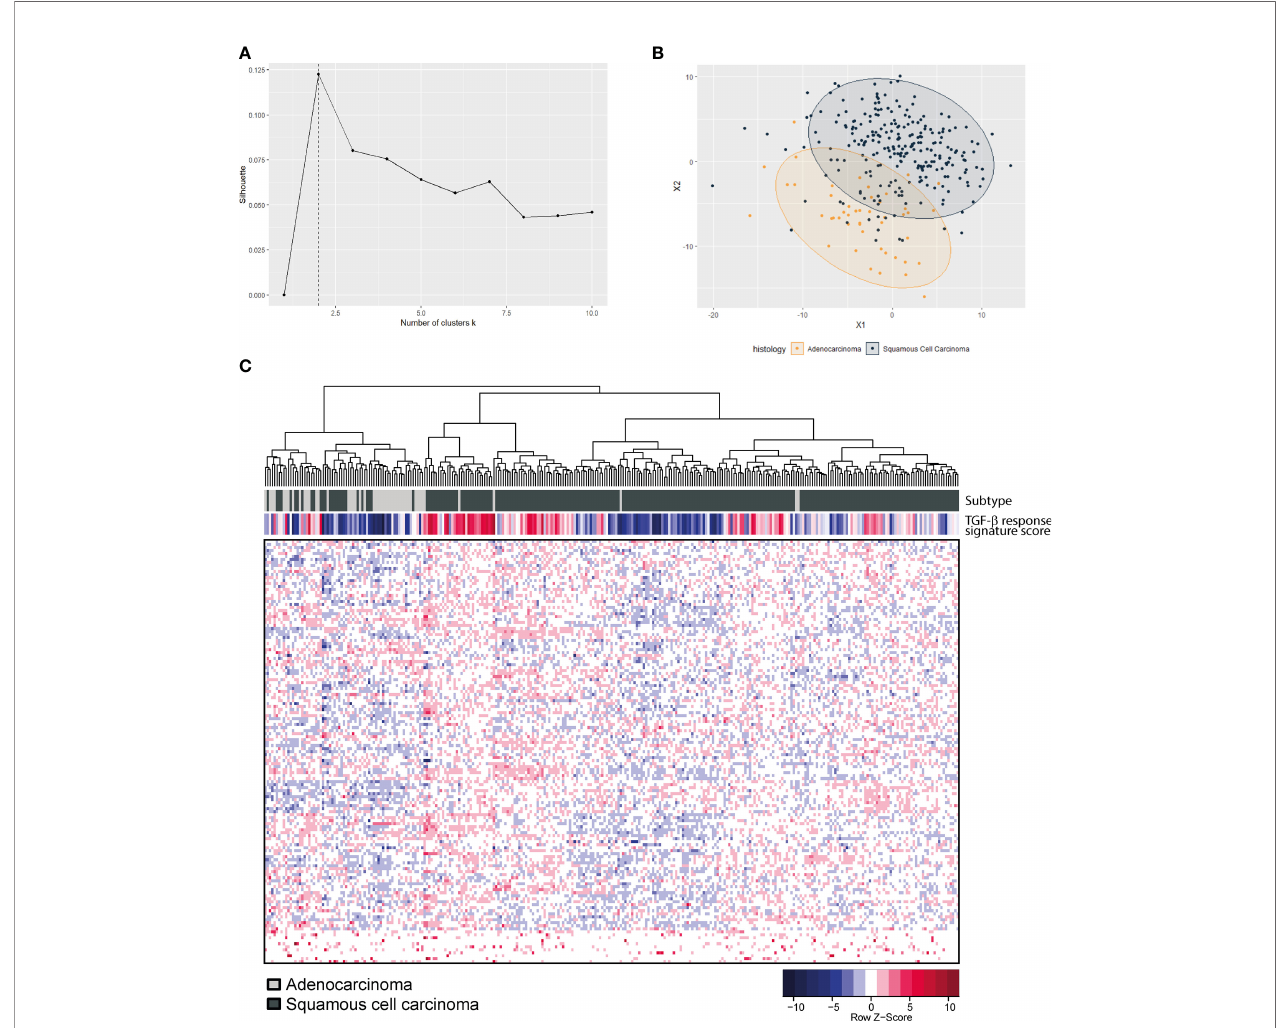
FIGURE 1 | TGF- b pathway gene expression in the TCGA cervical cancer dataset. (A) Optimal amount of clusters was calculated based on the silhouette value and was found to be two. (B) Multidimensional scaling shows a separate clustering of AC (yellow) and SCC (dark blue). (C) Heatmap showing unsupervised hierarchical clustering analysis of 144 SCC (dark grey) and 31 AC (light grey) patient samples on the X-axis and 153-gene TGF- b response signature genes on the